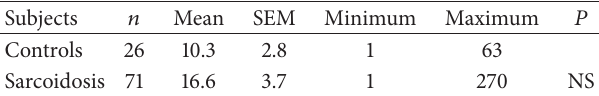
Table 2: IL-10 values (pg/mL) in serum of subjects with sarcoidosis and controls. Mean, SEM and